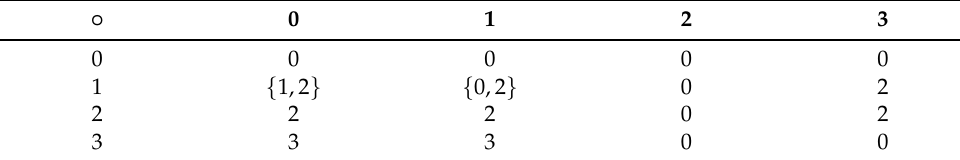
Table 15. Generalized anti-grouped quasi-hyper BZ -algebra.